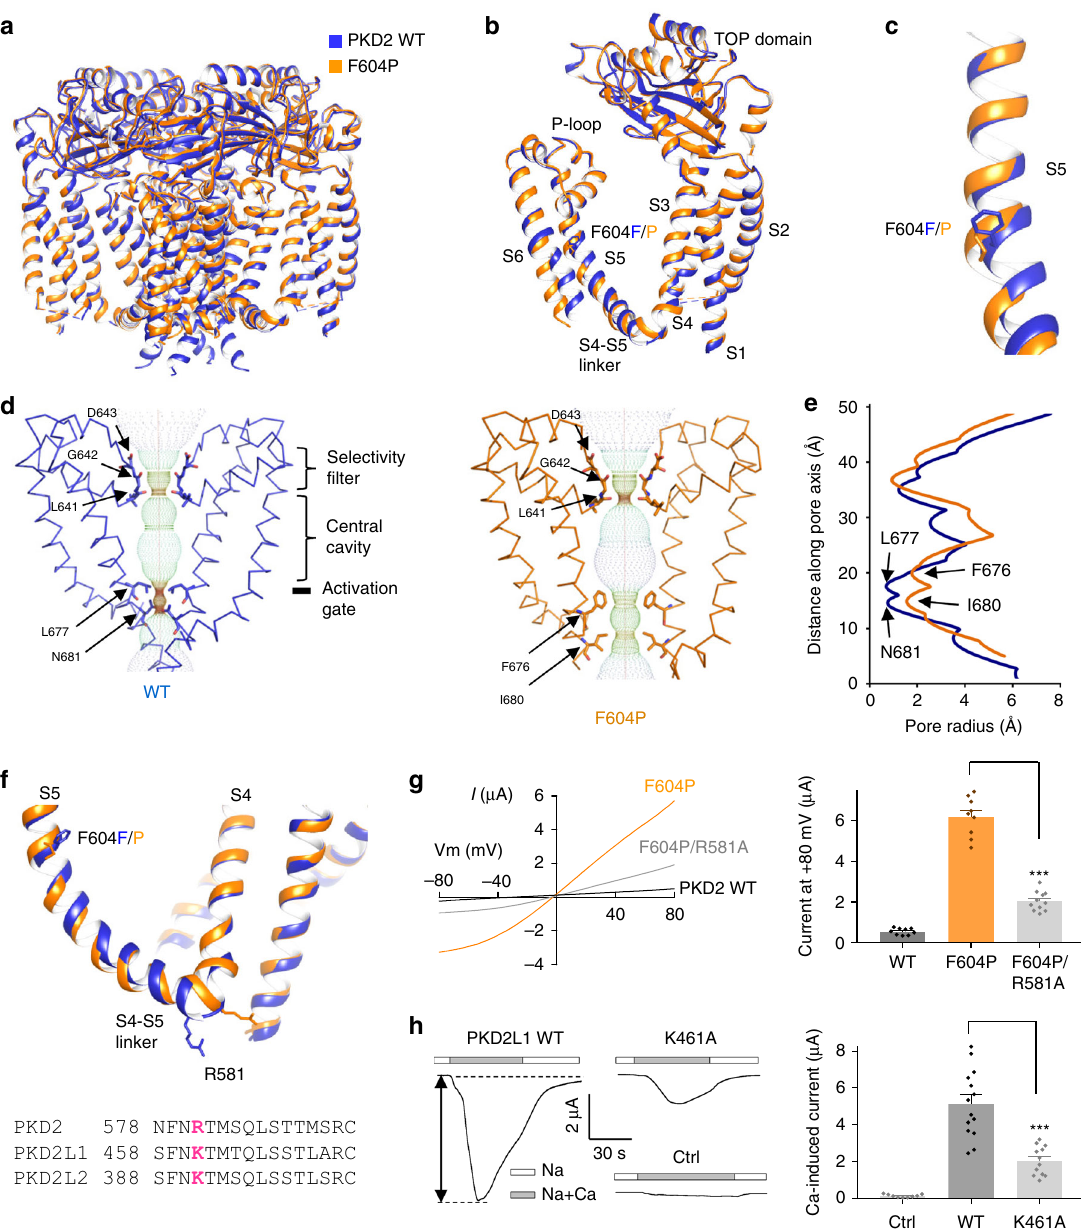
Fig. 5 Comparison of structure of PKD2 F604P with that of WT channel. a , b Side view of superposition of tetrameric ( a ) and subunit ( b ) structures of PKD2 F604P (orange) and WT (blue). c Comparison between S5 helix in PKD2 F604P and WT channels. The F604 and P604 residues are shown. d Solvent-accessible pathway along the pore mapped using the HOLE program for PKD2 WT and F604P structures. Residues forming the selectivity fi lter and lower constriction points are indicated. e Comparison between the pore radii, calculated with the program HOLE, for the PKD2 WT and F604P structures. f Upper panel, comparison between the S4-S5 linker in the PKD2 WT and F604P structures. The R581 at the beginning of the linker is shown. Lower panel, sequence alignment of S4-S5 linker of human PKD2, PKD2L1 and PKD2L2. The conserved cationic residues were highlighted in bold and magenta. g Left panel, Representative I - V curves for PKD2 WT, single mutant F604P and double mutant F604P/R581A obtained under the same condition as in Fig. 3a. Right panel, averaged currents at + 80 mV recorded from oocytes injected with cRNA of PKD2 WT or mutant F604P or F604P/R581A. Data are presented as mean ± SEM. *** P < 0.001 by Student ’ s t -test. h Left panel, representative whole-cell current traces obtained from control oocytes (Ctrl, water-injected) or oocytes injected with cRNA of human PKD2L1 WT or mutant K568A. Oocytes were voltage clamped at − 50 mV and currents were recorded using Na-containing solution (see Fig. 1b) without (Na) or with addition of 5 mM CaCl 2 (Na + Ca). The Ca-activated peak current, indicated by the double arrowed line, was measured to assess PKD2L1 channel activation. Right panel, averaged Ca-activated peak currents from oocytes expressing PKD2L1 WT or K461A mutant or water-injected oocytes (Ctrl). Data are presented as mean ± SEM. *** P < 0.001 by Student ’ s t